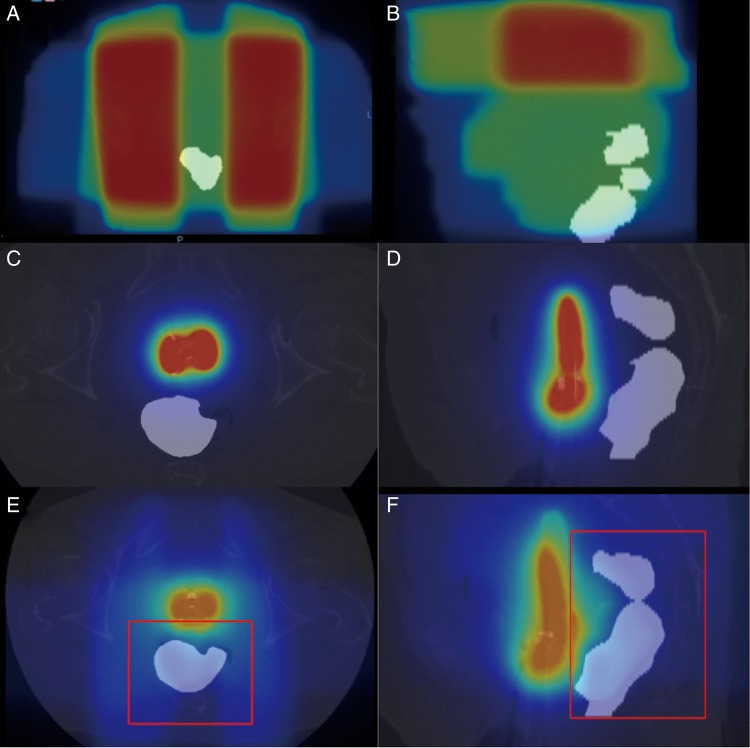
The typical dose distribution projected to CT images before and after DIR. (A) The dose distribution of EBRT before DIR from axial view. To make it easy to see, CT values within a rectal contour and tandem/ovoid applicator and outside them were replaced using in-house software; (B) sagittal view. (C) The dose distribution of ICBT before DIR from the axial view; (D) sagittal view. (E) The cumulative dose distribution after DIR. An area surrounded by the red line displayed a rectangular parallelepiped volume of interest that included the rectal contours.Abbreviations: CT = computed tomography, DIR = deformable image registration, EBRT = external beam radiotherapy, ICBT = intracavitary brachytherapy.